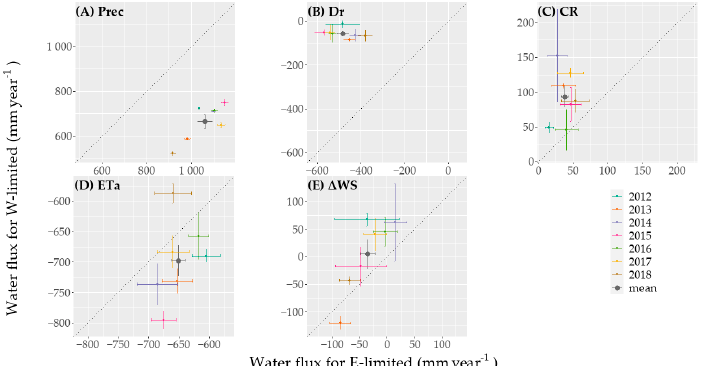
Figure 1. Mean monthly values of the precipitation (Prec), actual evapotranspiration (ETa), drain- age (Dr), upward water flow (CR), and average air temperature (T air ) for ( A ) Rollesbroich the en- ergy-limited site (E-limited) and ( B ) Selhausen the water-limited site (W-limited). Positive values represent an input and negative values a loss of water for the system.